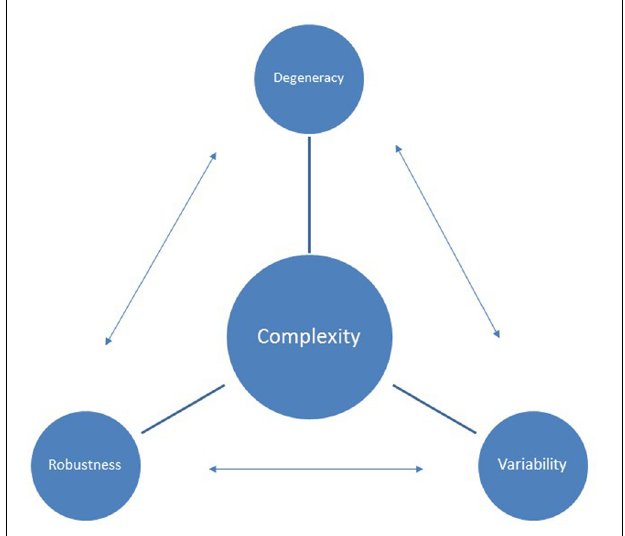
FIGURE 2 | Inter-relationships between complexity and injury